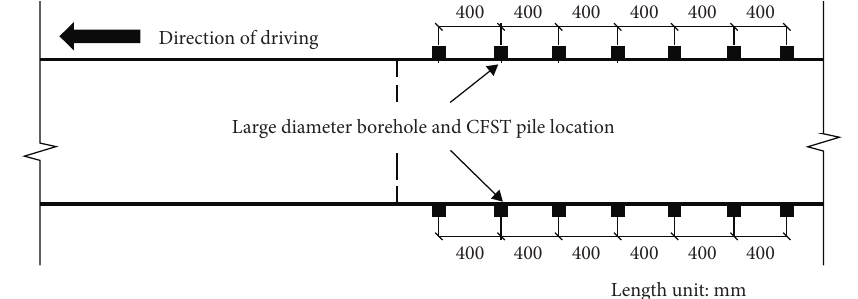
Figure 18: Large diameter borehole and CFST pile layout.